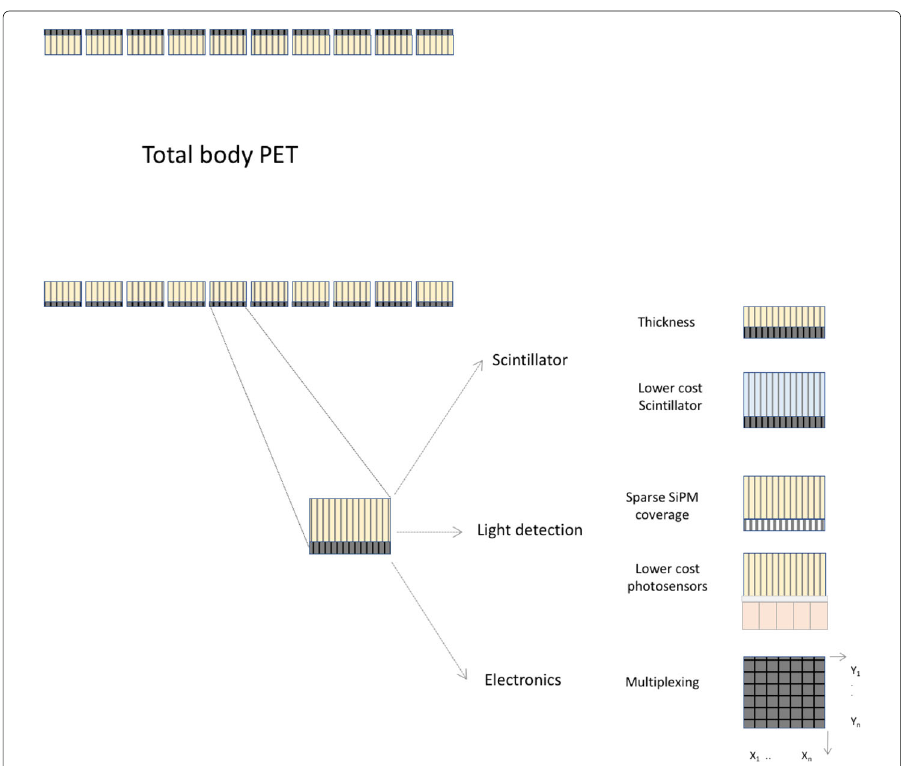
Fig. 12 Different options to reduce the cost of the detectors (scintillator, sensor, electronics) in total body PET systems